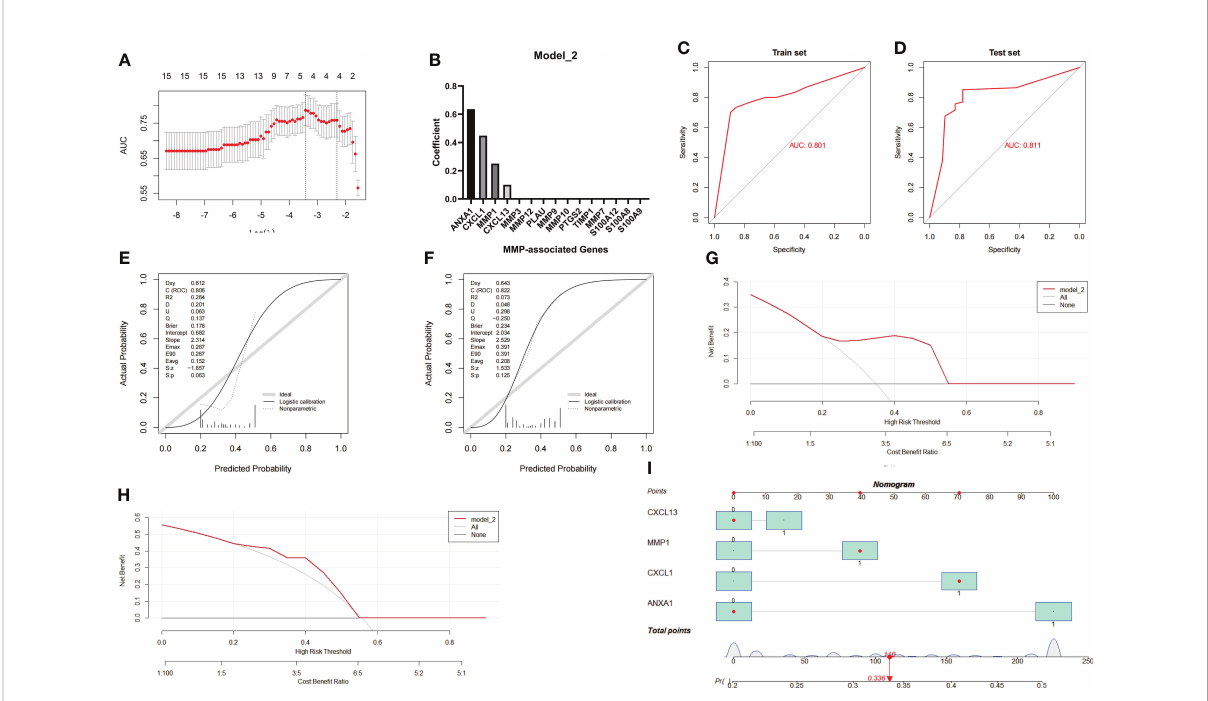
FIGURE 6 Establishment and evaluation of Model_2 with the MMP-associated module. (A) Selection of the optimal parameter (lambda) in the LASSO model. (B) Plot of coef fi cients obtained by LASSO. ROC curve (C, D) , calibration curves (E, F) , and decision curve analysis (DCA) (G, H) of the training and testing cohort models. (I) Nomogram of Model_2 for the predictive value of CD/UC is